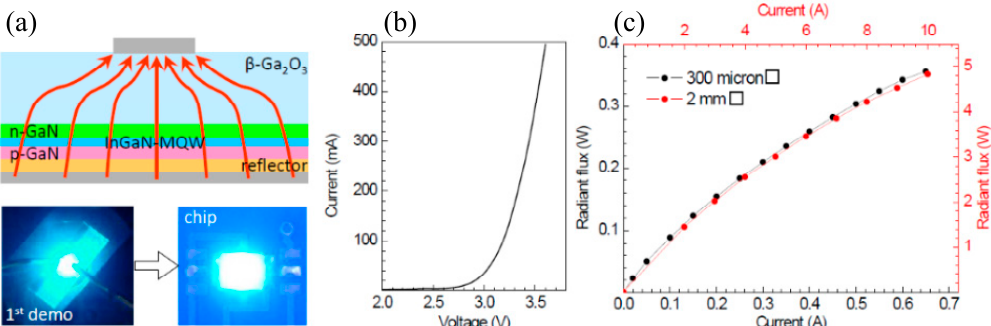
Figure 15. ( a ) Schematic of a blue-LED based on an InGaN-MQW deposited on a β -Ga 2 O 3 substrate. Photograph of the initially demonstrated blue emission by vertical current injection in comparison with a current chip. ( b ) I–V characteristic of a blue-LED on β -Ga 2 O 3 substrate. ( c ) Radiant flux as a function of the vertical current flow for two different chip areas, 300 µm (left-down black coordinates) and 2 mm (up-right red coordinates), respectively. The radiant fluxes were measured with an integrating sphere. Reprinted with permission from Reference [64]. Copyright 2014 SPIE.